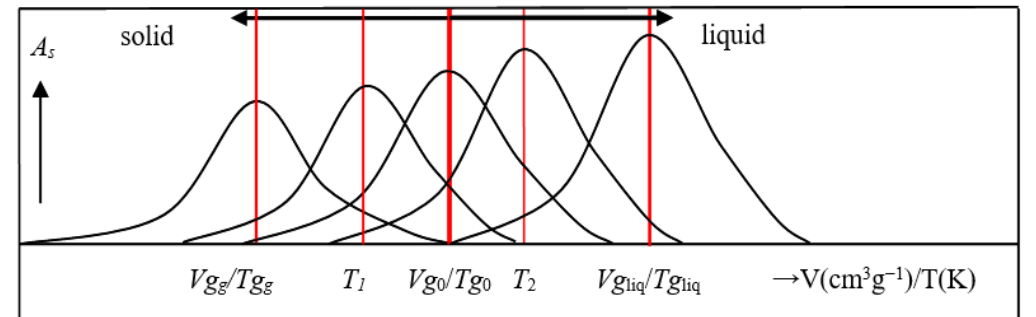
Figure 7. Influence of the vibration width at a chosen specific temperature (schematic). At Tg g all vibration widths V i are smaller than Vg 0 . The solid state is given. When the temperature is raised to T 1 , some V i exceed Vg 0 and the total system consists of a solid matrix surrounding liquid droplets. At Tg 0 , about half of the total system (see section “Location of Tg 0 in the transition interval”) is solid and the other half liquid. At the temperature T 2 , the system consists mainly of the liquid phase, which contains a proportion of solid particles. At Tg li q the system is pure liquid, because no single V i is lower than Vg 0 . ( A s are the vibration amplitudes).